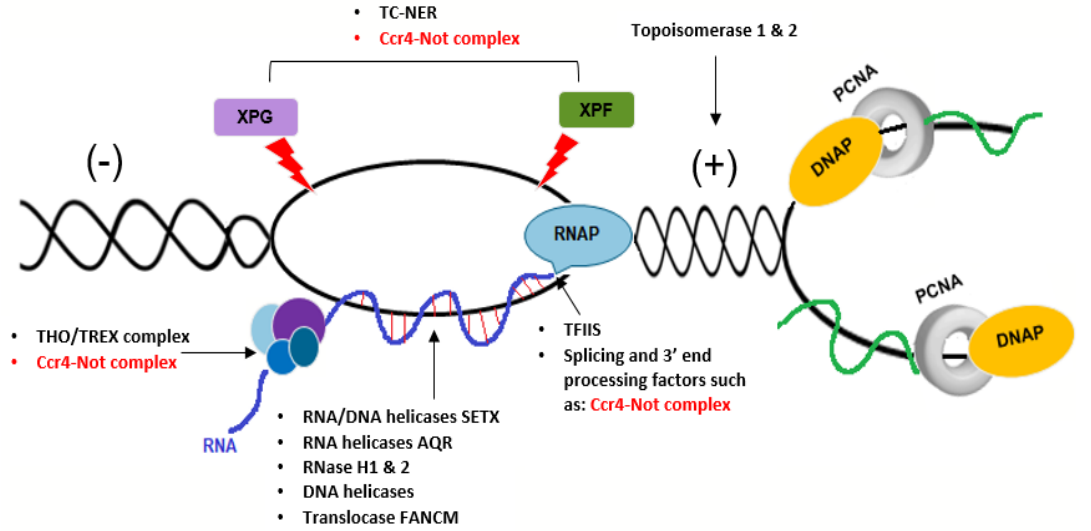
Figure 3. The potential roles for the Ccr4–Not complex in repair of R-loops. Three groups of surveillance factors are involved in repair of R-loops; the first group, such as THO/TREX complex, binds to nascent RNA and prevents the hybridization between the ssDNA template and the nascent RNA. The second group, such as topoisomerases, co-transcriptionally contributes to the overall stability and processivity of RNA Pol II splicing and 3′ end processing factors. The final group actively removes the R-loop structures; for example, the RNA/DNA helicases such as Senataxin (SETX) and/or Aquarius (AQR), DNA helicasetranslocase FANCM and RNase H enzymes. We suggest that the Ccr4–Not complex can contribute to function of all these factors as shown.